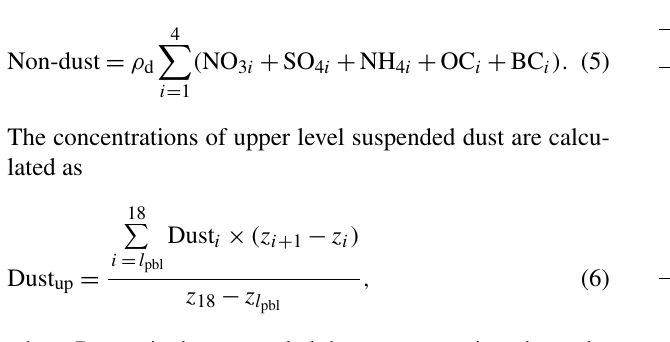
Table 2. WRF-Chem model configuration